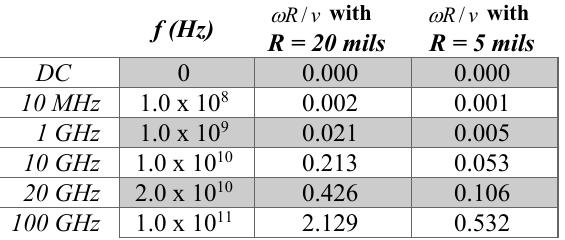
Table 1: Values of / in typical PCB environment with with f (Hz) R = 20 mils R = 5